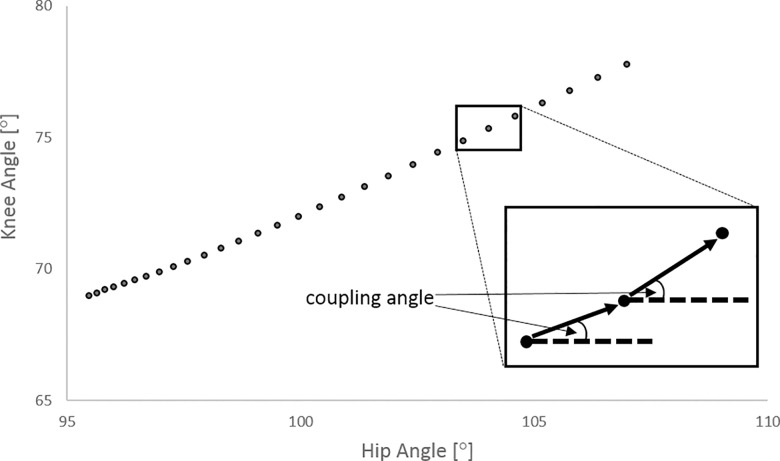
Schematic representation of Vector Coding.